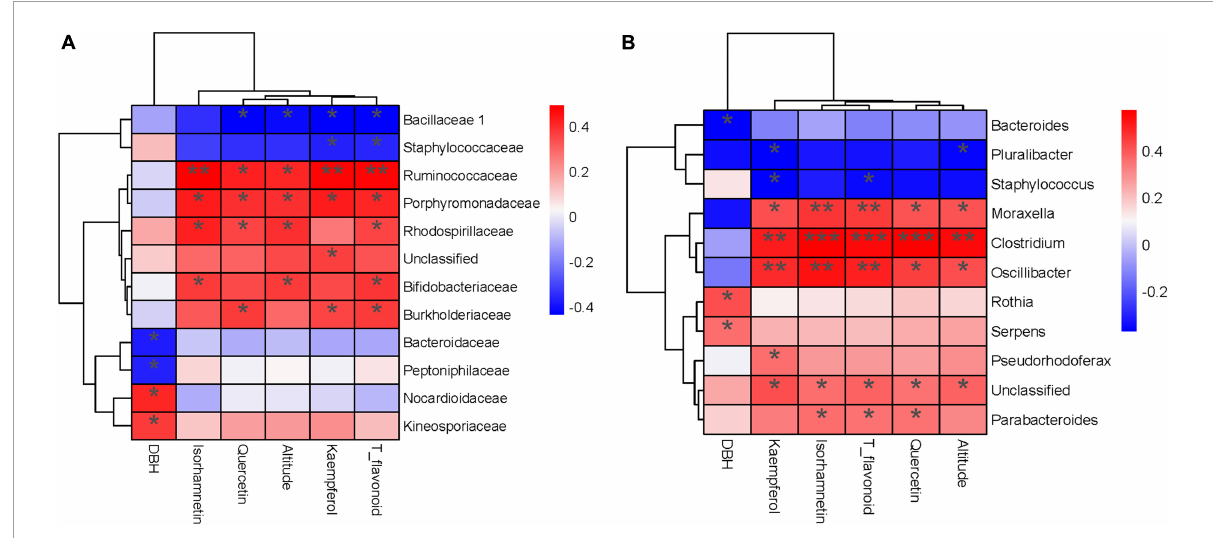
FIGURE5 Heatmap (A) The correlation test between families and factors. (B) The correlation test between genera and factors. (***) p < 0.001, (**) p < 0.01 and (*) p <